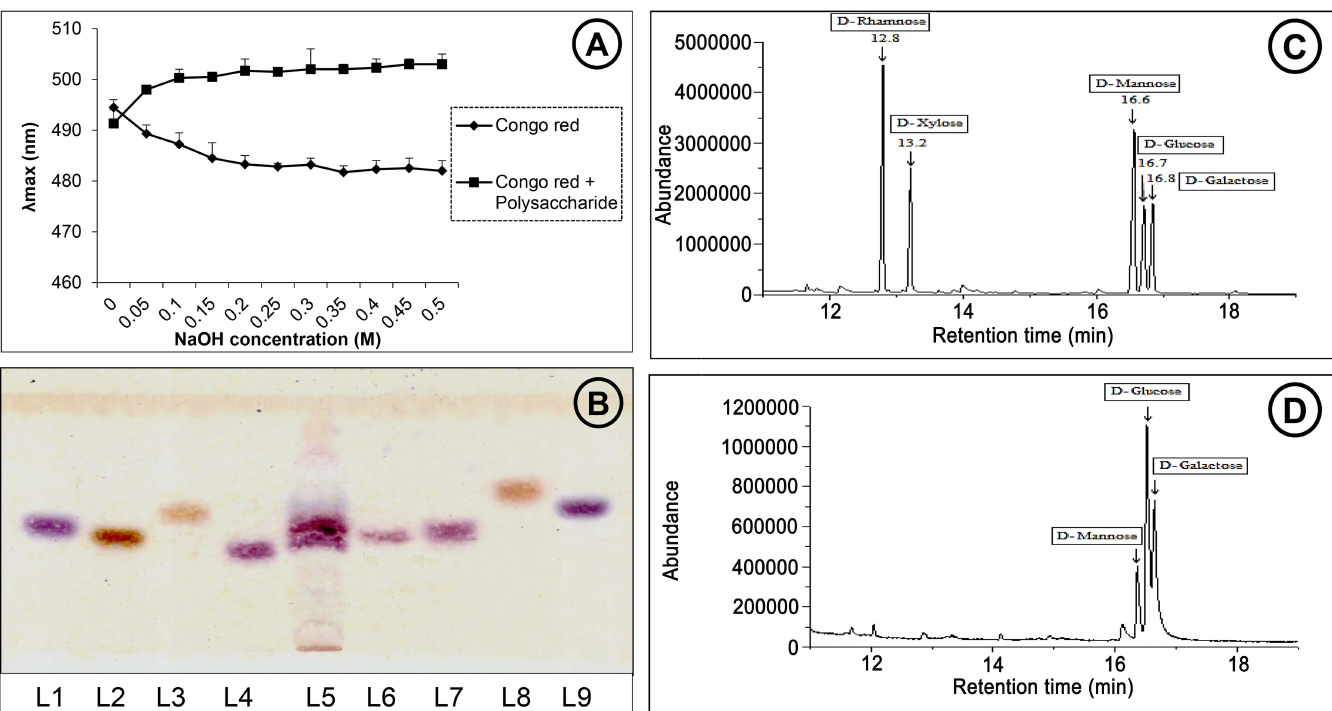
Fig 1. A: Changesin the absorption maximum of the congored-polysaccharide complex at variousconcentrations of sodium hydroxidesolution;B: HPTLC analysisfor monosaccharide compositionof the polysaccharide. L1: L-Arabinose L2: D-Fructose, L3: D-Fucose, L4: D-Galactose, L5: Polysacchaide, L6: D-Glucose, L7: D-Mannose,L8: D-Rhamnose, L9: D-Xylose; C: GC-MS of five standard monosaccharides and D: GC-MS of polysaccharide from P . flabellatus .